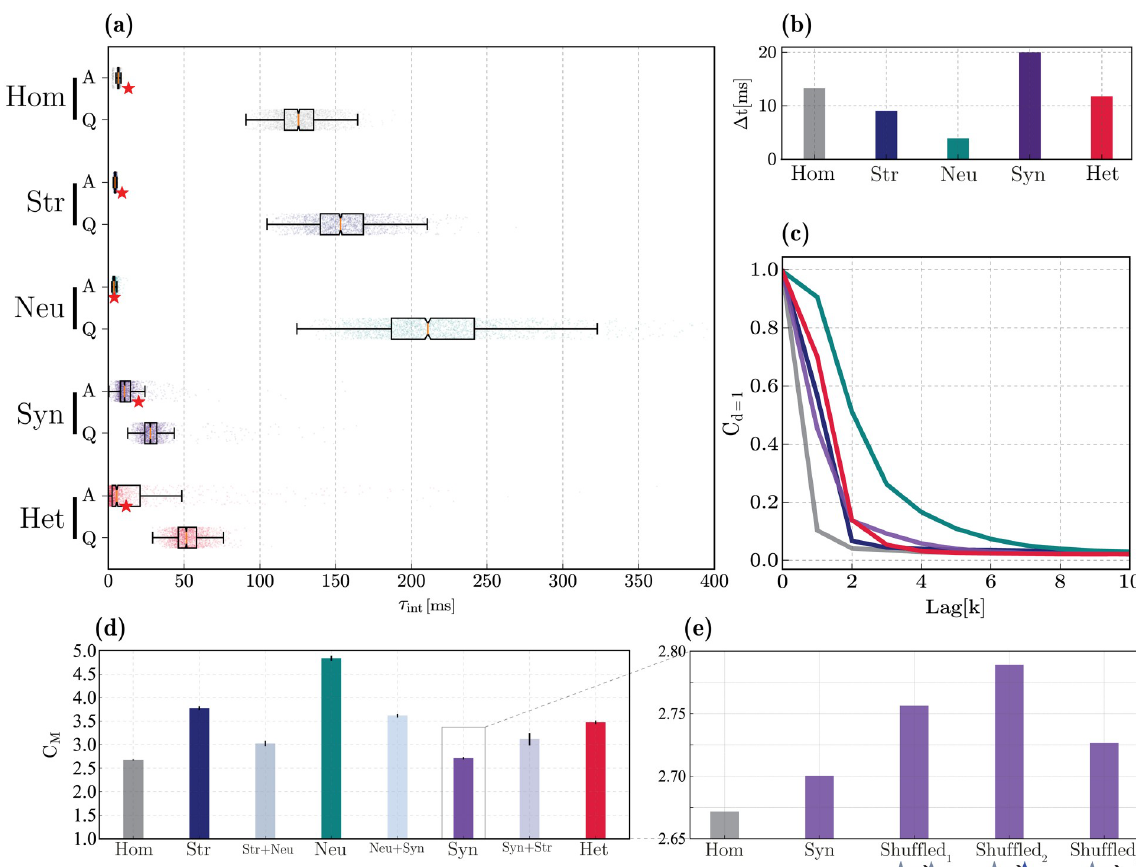
Fig 7. Temporal tuning and linear memory capacity. ( a ): distributions of intrinsic timescales ( τ int ) in the quiet (Q, bottom) and active (A, top) states, for each of the different conditions. ( b ) Optimal stimulus resolution ( Δ t ) that allows each circuit to perfectly track its input signal (see also red star markers in ( a ) and S4 Fig). ( c ): Fading memory functions for the different heterogeneity conditions, determined as the ability to reconstruct the input signal at different delays (k). Colours as in panel ( d ) below. ( d ): Total memory capacity, corresponding to the area under the curves in ( c ). Apart from the main conditions depicted in ( c ), pair-wise combinations among conditions are depicted in between. ( e ) Effects of synaptic heterogeneity on memory capacity, in conditions where the weight distributions are fixed, but re-shuffled such that the strongest weights are assigned to the connections among the input population (Shuffled 1 ), from the input population to all excitatory neurons (Shuffled 2 ), or from the input population to all neurons (Shuffled 3 ). Results depicted in ( b ), ( d ) and ( e ) were gathered from 10 simulations per condition.